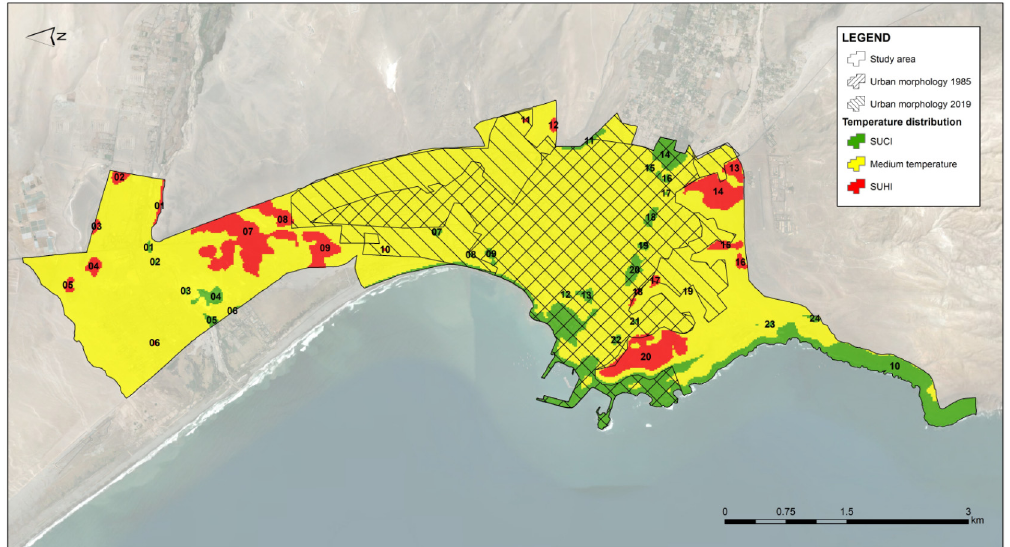
Figure 4. Mean surface temperatures in Arica between 1985 and 2019.